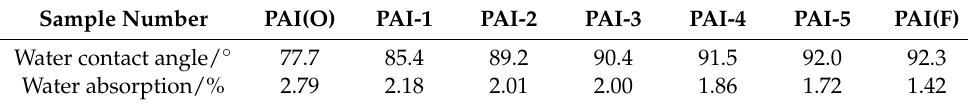
Table 6. Water contact angle and water absorption rate of synthetic PAI